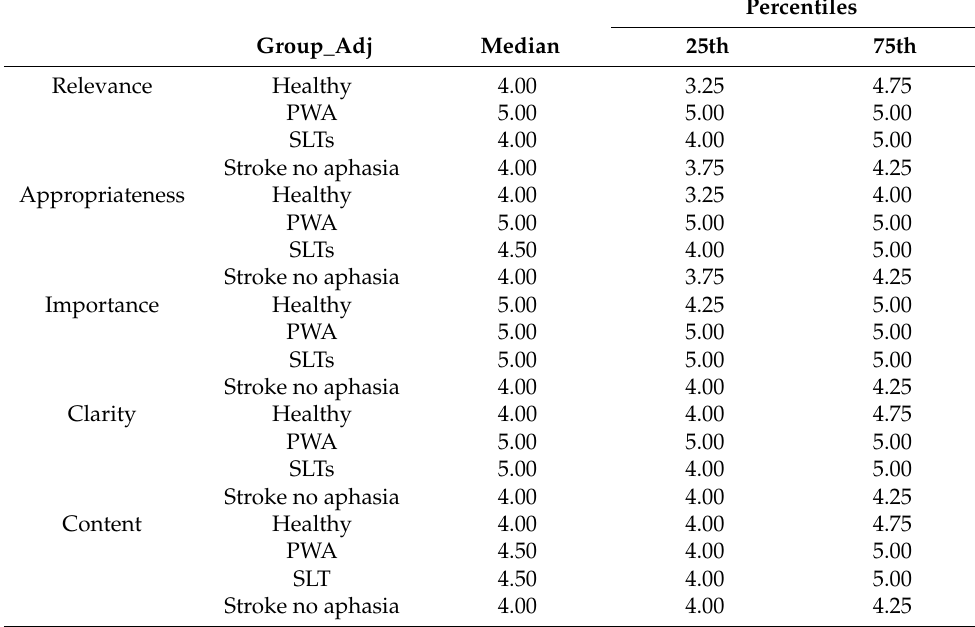
Table 8. Median Scores of Each Group in Each Subcategory of the